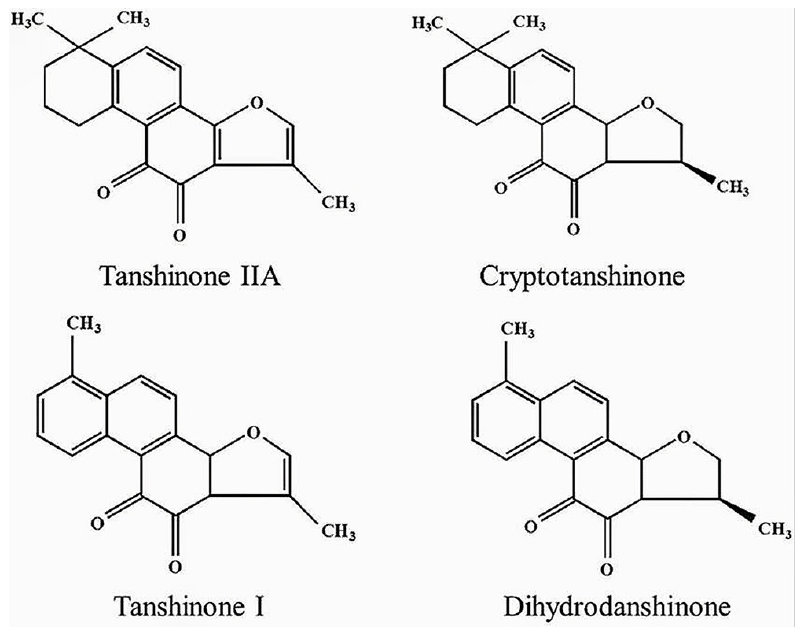
Figure 1. Chemical structures of four Tanshinone monomers.